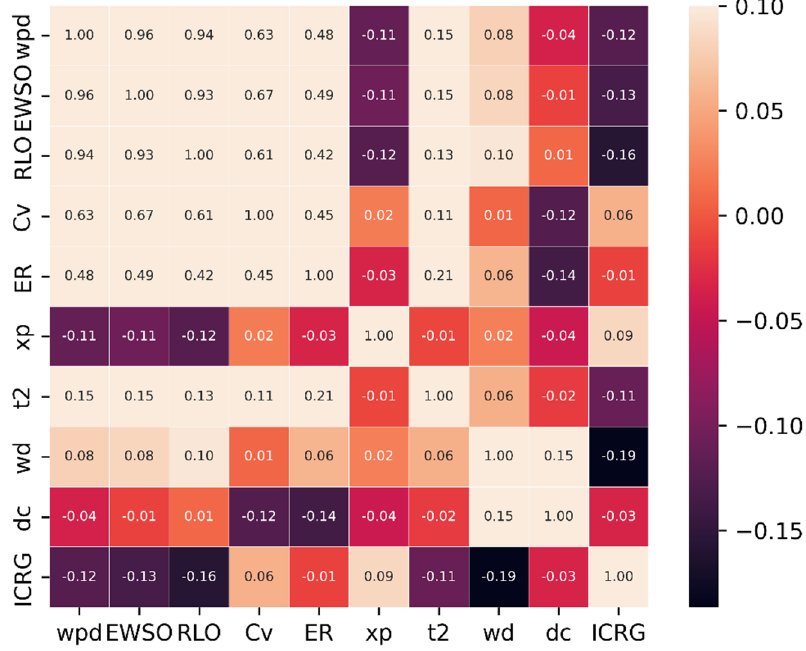
Figure 2. Correlation coefficient heatmap before principal component analysis.